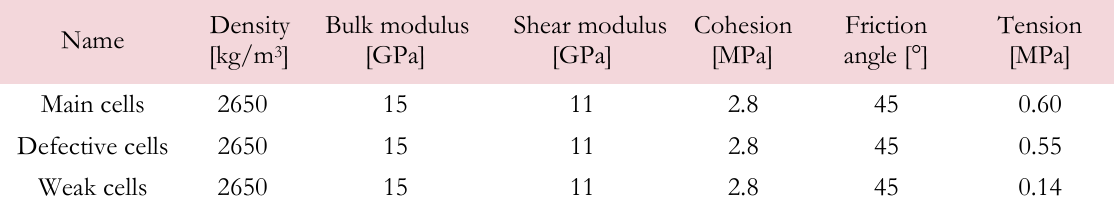
Table 1: Physical and mechanical parameters of the